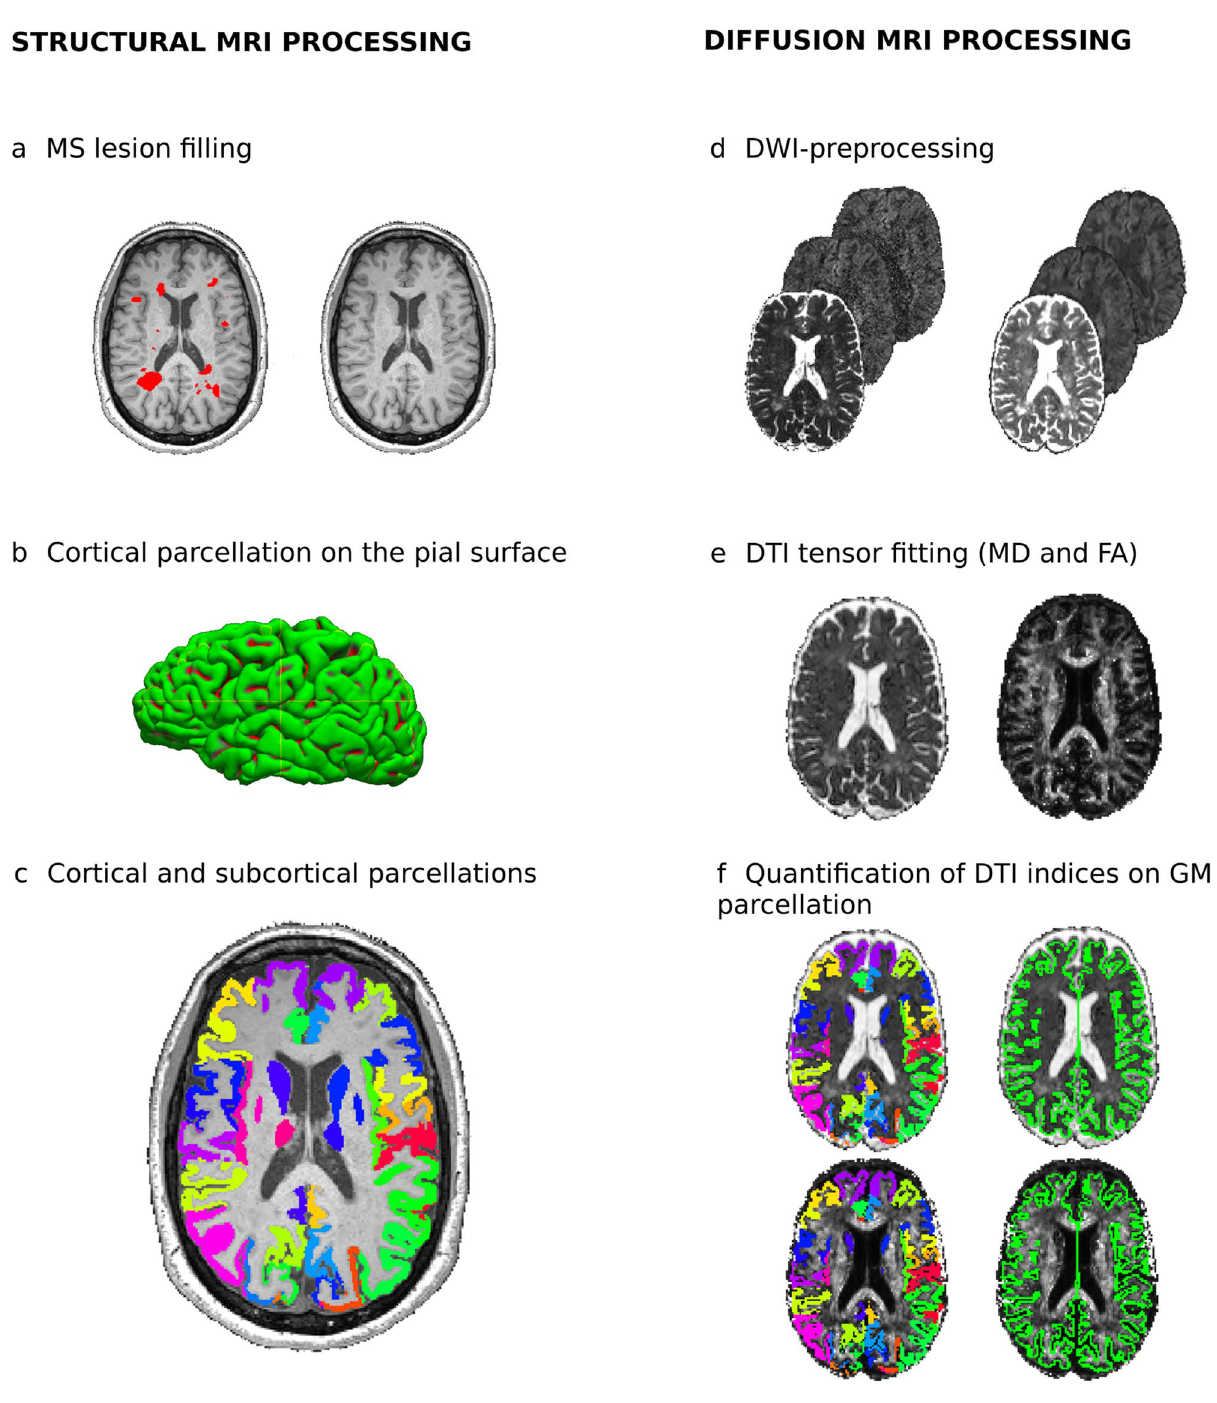
Figure 4. Flowchart for the structural (left) and diffusion MRI processing (right). To quantify GM volume (left), WM lesions in the 3D-MPRAGE were segmented using 3D-FLAIR as a reference and a WM lesion-filling approach was applied ( a ). We parcellated both the cortical pial surface ( b ), and the cortical and subcortical GM regions, to obtain volumetric values in 76 regions. To calculate the diffusion metrics in each region (right), after performing the standard diffusion pre-processing steps ( d ) we obtained the mean diffusivity and fractional anisotropy measures ( e ), which was realigned to the cortical and subcortical surface on the diffusion tensor imaging space ( f